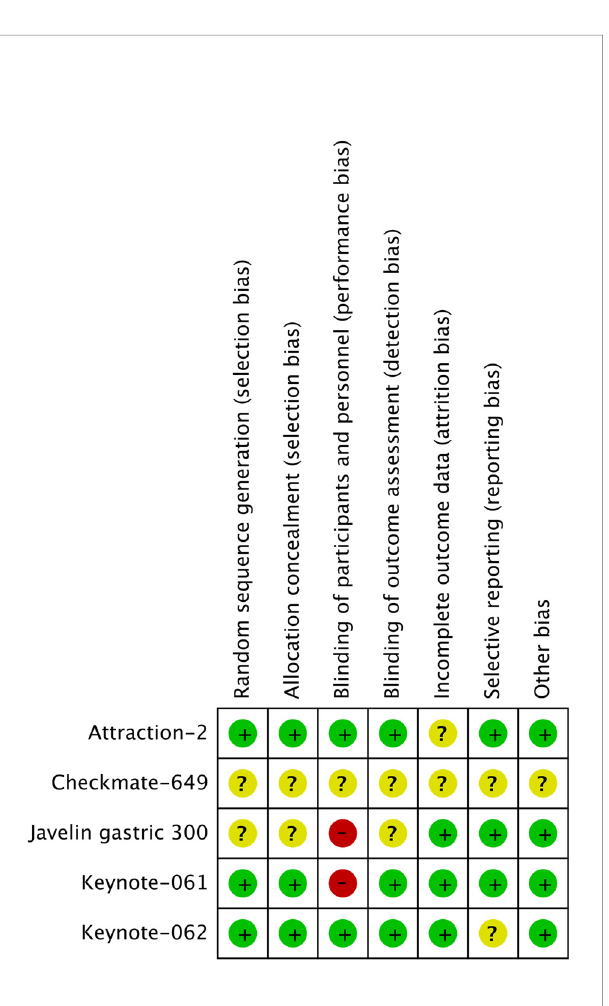
FIGURE 2 | Quality assessment of included studies with full article published. Checkmate-649 and JAVELIN gastric 100 only provided meeting